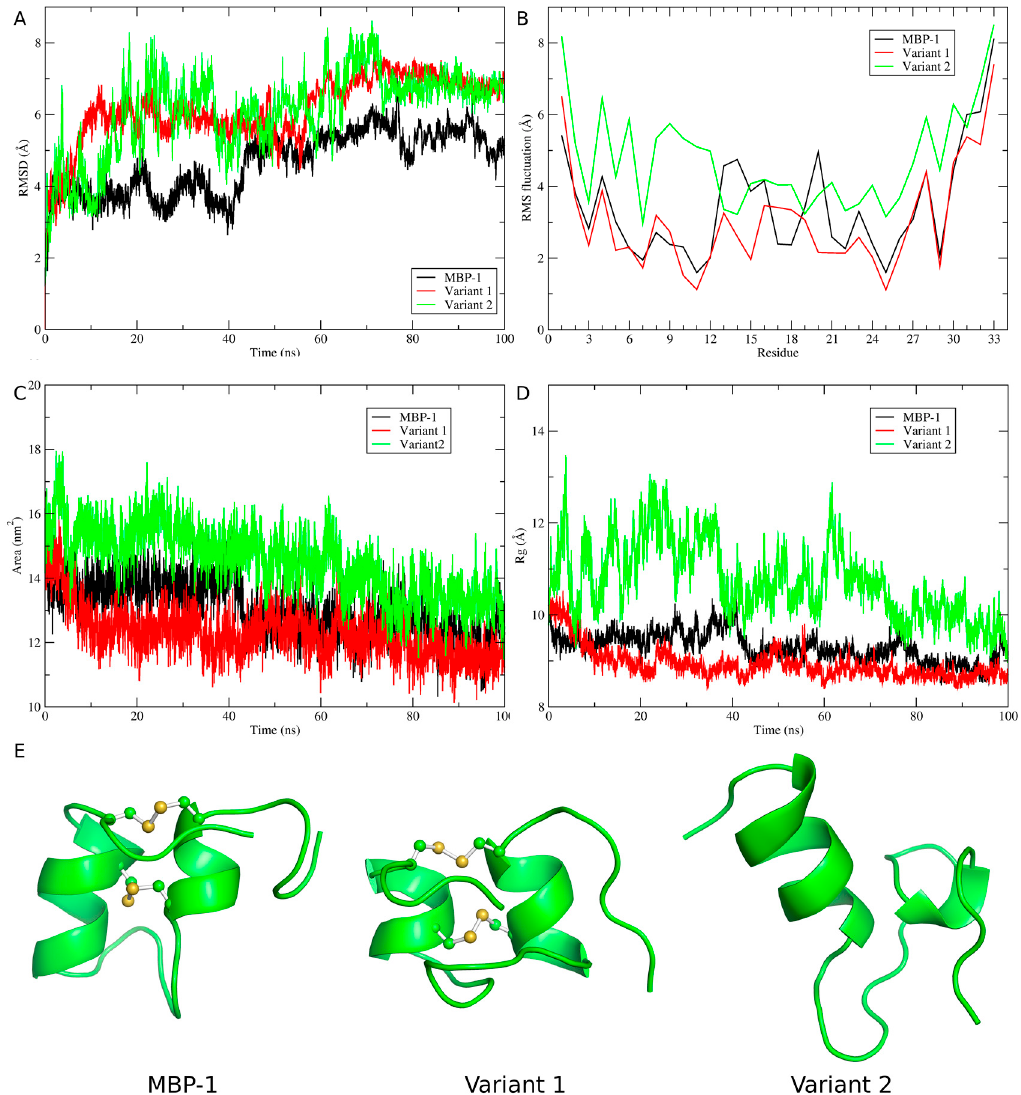
Figure 3. Analysis of molecular dynamics trajectories of MBP-1 (black), variant 1 (red) and variant 2 (green). ( A ) Backbone RMSD variation during the simulations; ( B ) RMS fluctuation by residue; ( C ) the solvent accessible surface area; ( D ) the variation of radius of gyration during the simulations; and ( E ) the final structures at 100 ns of simulation.